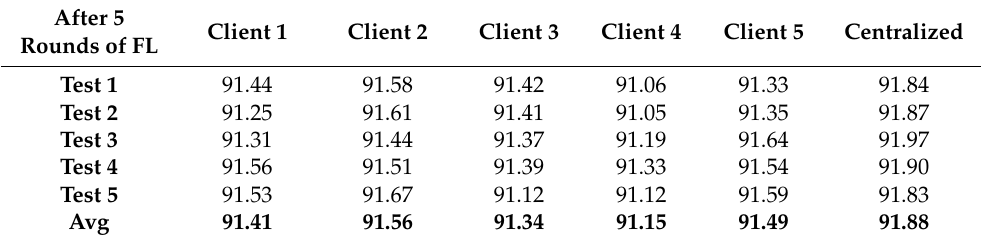
Table 4. Comparison of recall between different clients and centralized model.